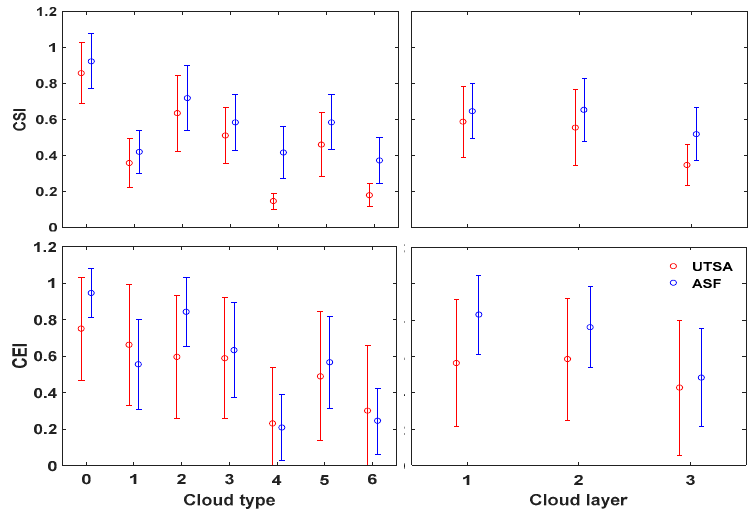
Figure 6. The mean CSI and clear-sky energy index (CEI) indices with their ±1 standard deviation error bars derived from all available data with the 5-min sampling interval as a function of cloud types ( left panels ) and cloud layers ( right panels ) (see Table 1) at the two sites.